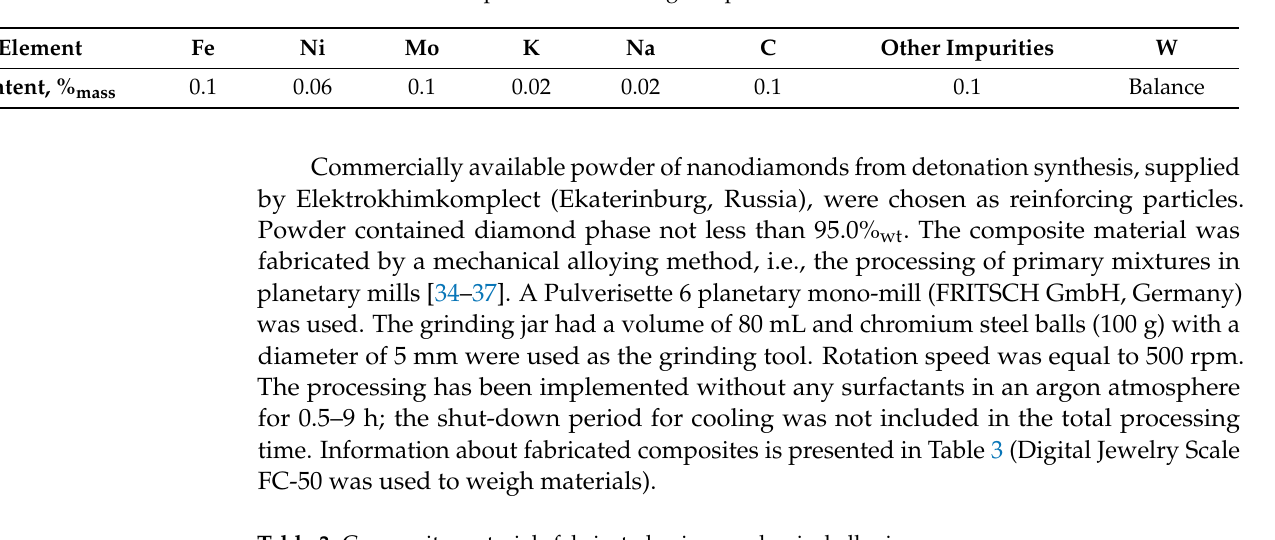
Table 2. Chemical composition of the tungsten powder.